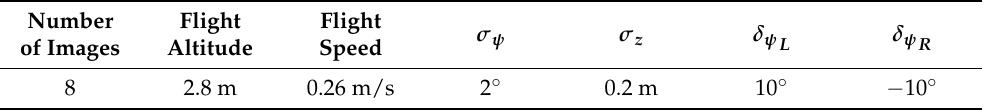
Table 5. Experimental